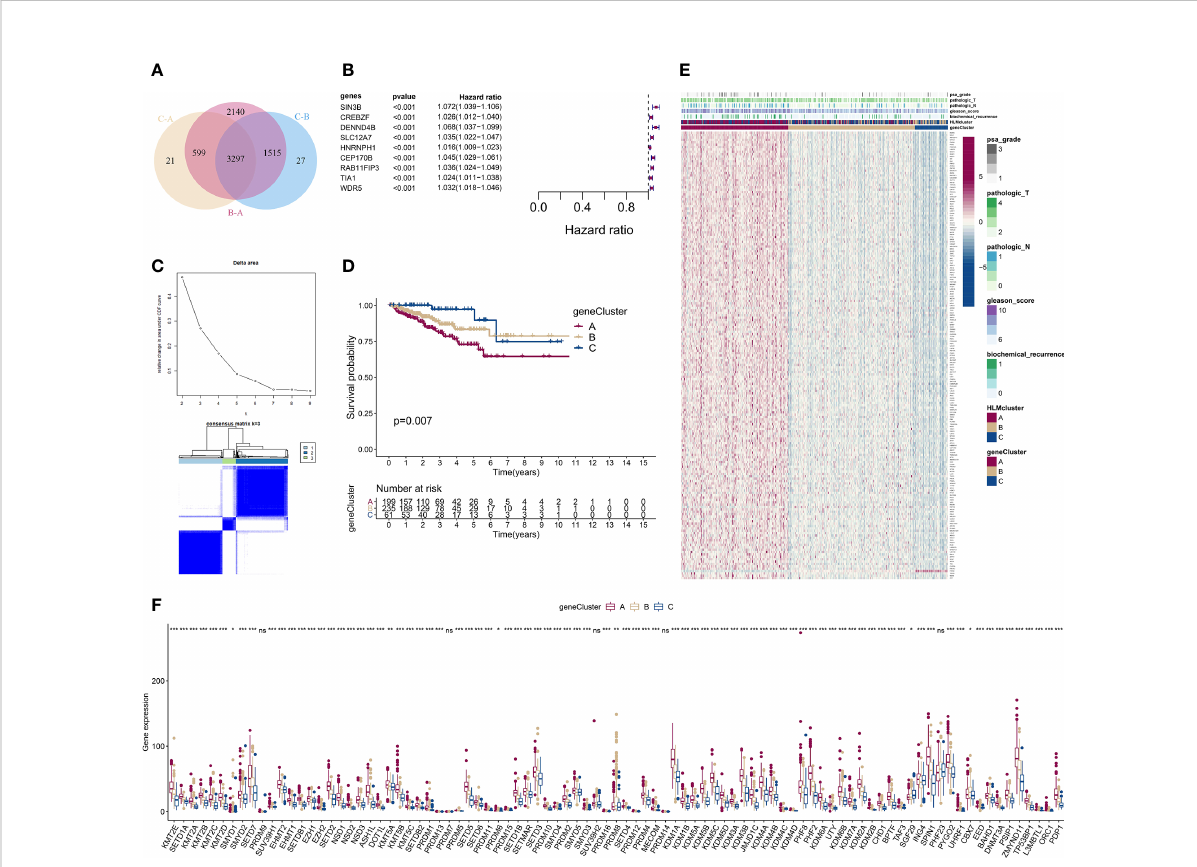
FIGURE 6 Consensus clustering analysis based on 189 HLM phenotype-related genes. (A) Intersecting DEGs identi fi ed in every pairwise comparison of HLMclusters are shown as a Venn diagram. (B) Univariate Cox regression analysis for RFS was performed in relation to 3,297 intersecting genes. The statistical signi fi cance (P in the Kaplan – Meier survival and Cox regression analysis < 0.001) of 9 genes (SIN3B, CREBZF, DENND4B, SLC12A7, HNRNPH1, CEP170B, RAB11FIP3, TIA1, and WDR5), P value, and HR value (with 95% con fi dence interval (CI)) are shown in the plot. (C) Consensus clustering analysis based on the 189 HLM phenotype-related genes (overlap in the pairwise comparisons of HLMclusters and P < 0.01 in the Cox regression analysis) was performed. (up) Relative change in area under the CDF curve from k = 2 to 9. (down) Color-coded heatmap of the consensus matrix for k = 3. Color gradients represent values from 0 – 1: white: 0; dark blue: 1. (D) RFS analysis among the three geneClusters using Kaplan – Meier curves. Log-rank P values are shown in the graph, and the numbers of at-risk patients are shown at the bottom. (E) The expression levels of 189 HLM phenotype-related genes in the unsupervised three geneClusters were estimated, and the distribution of the various clinicopathological characteristics of TCGA-PRAD are shown as a heatmap. PSA grade, pT, pN, GS, biochemical recurrence, and HLMclusters were used for patient annotation. Red in the heatmap, high expression; blue, low expression. (F) Boxplot of the expression levels of HLM regulators among the three geneClusters. The values of the median ± interquartile range are shown in the graph. ns P > 0.05; * P < 0.05; ** P < 0.01; ***P <